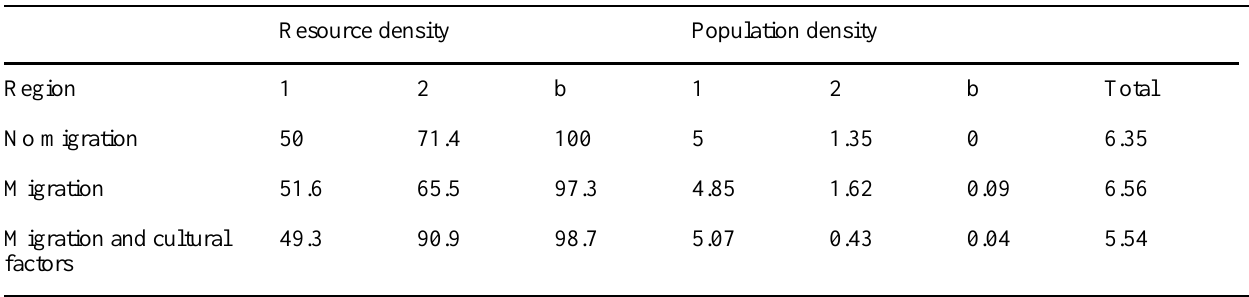
Table 2 . Summary of equilibrium population and resource densities with and without migration. Resource